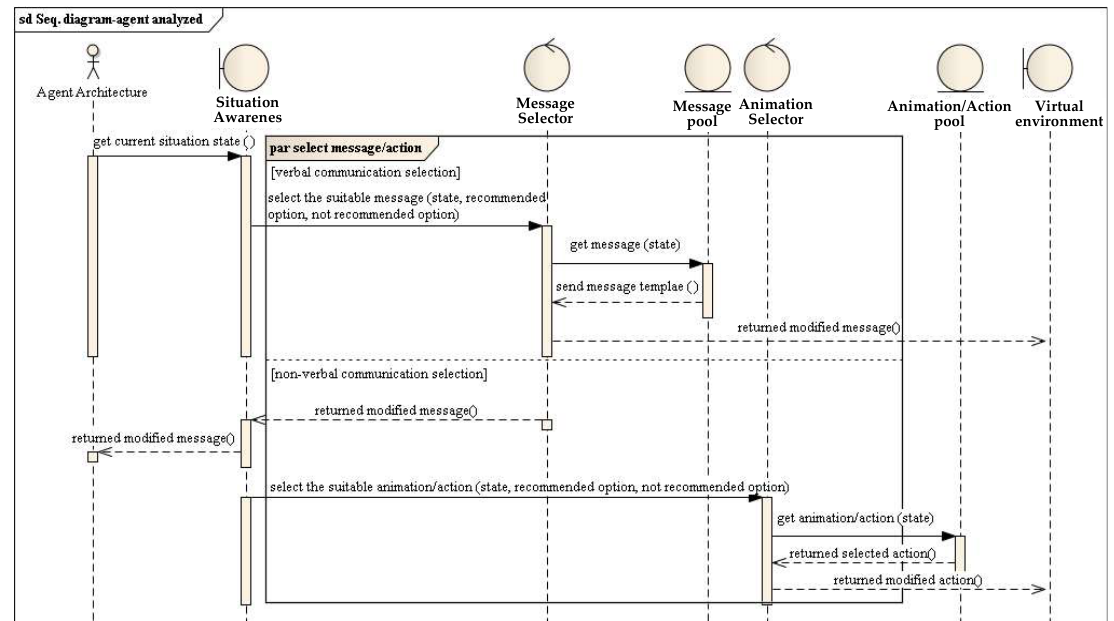
Figure 6. Verbal and nonverbal human–IVA communication in HAT-CoM.